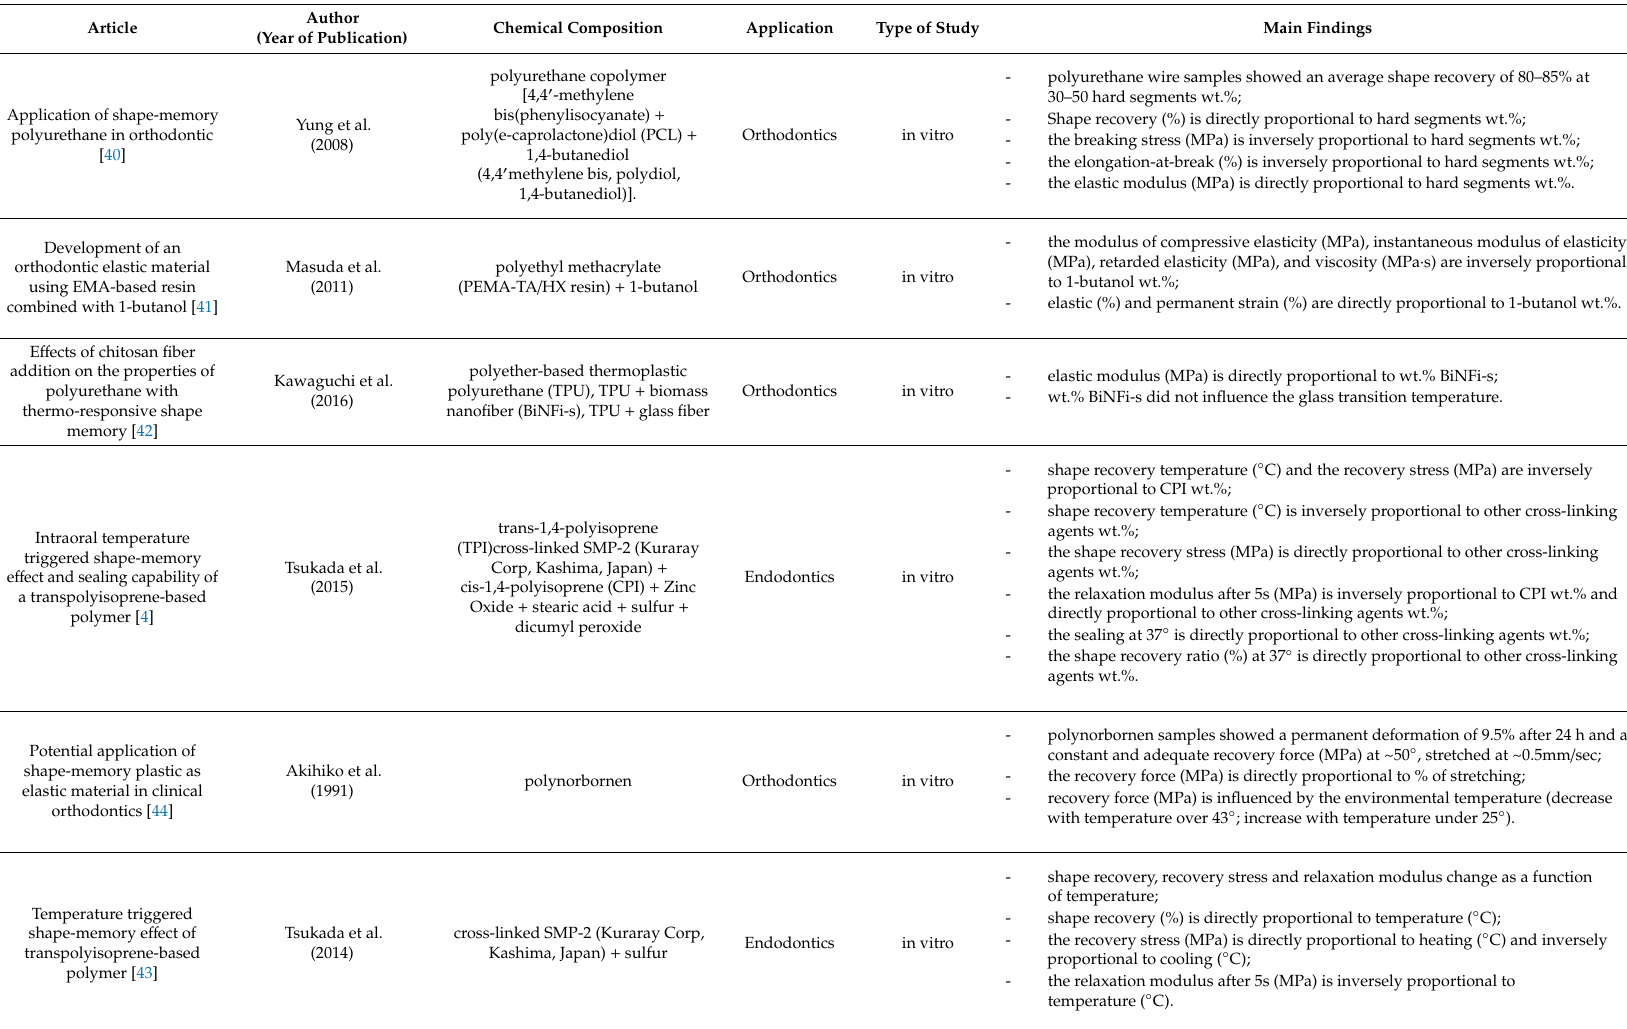
Table 7. Articles included in the systematic